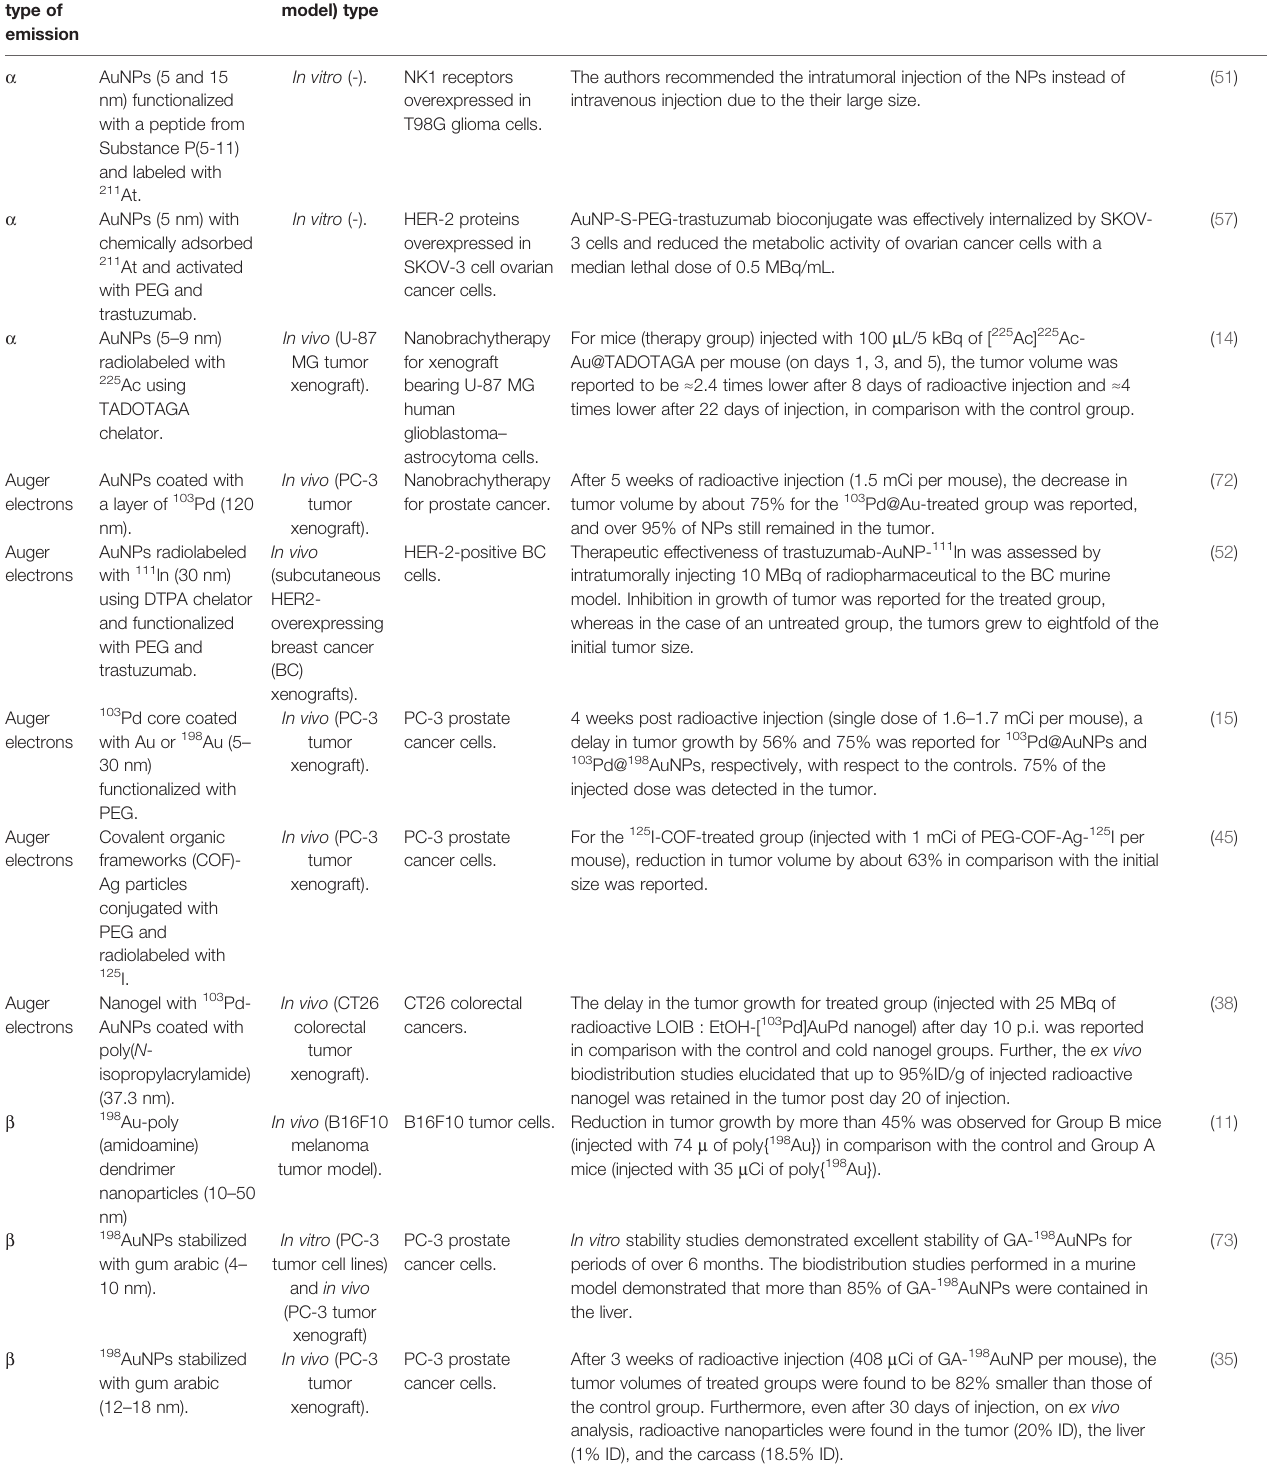
TABLE 2 | Summary of nanobrachytherapy-based preclinical